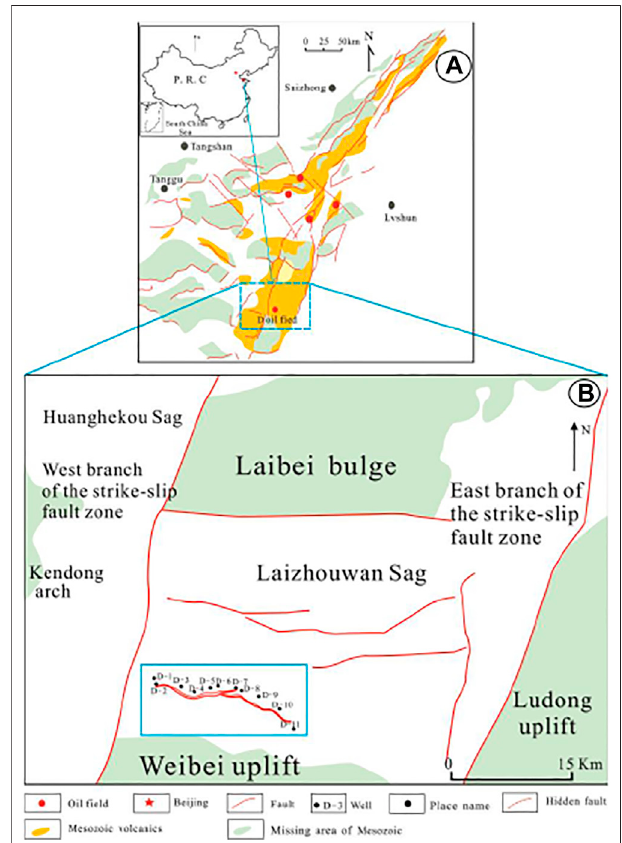
FIGURE 1 | Distribution and structural location of main oil and gas fi elds in the Kenli area. (A) is the Laizhouwan sag location map. (B) is the D oil fi eld location map. (C) is the D oil fi eld well location map. using CorelDRAW 2018